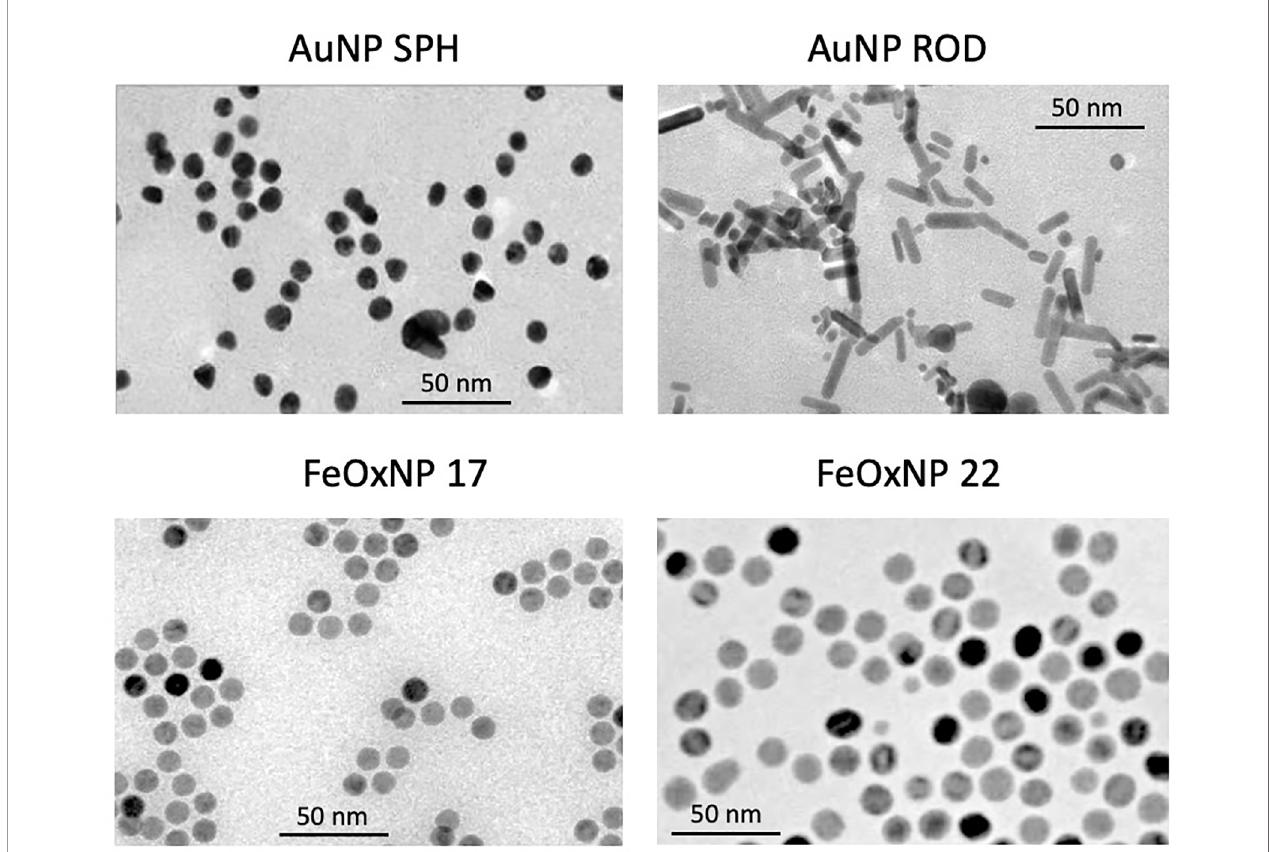
FIGURE 1 | Size and morphology of the AuNP and FeOxNP used in this study. TEM images of spherical AuNP (upper left panel), rod-shaped AuNP (upper right panel), FeOxNP 17 (lower left panel) and FeOxNP 22 (lower right panel). Size bars (50 nm) are shown in each panel.